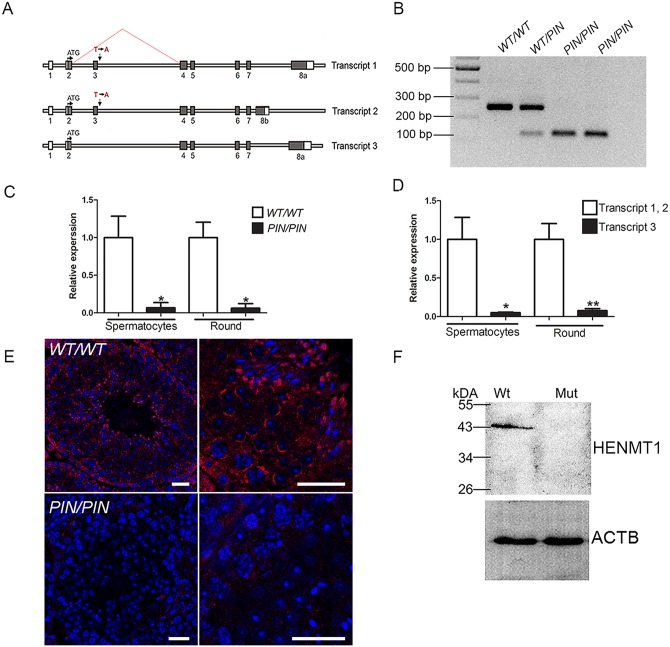
The Henmt1
PIN/PIN mutation resulted in exon 3 skipping, the production of unstable Henmt1 mRNAs and an absence of HENMT1 protein in the testis.
(A) A schematic representation of the three Henmt1 transcripts and the effect of the Henmt1
PIN/PIN on exon 3 splicing. Boxes represent exons, open bars represent introns. (B) RT-PCR analysis using primers located in exons 2 and 4 confirmed the skipping of exon 3 in the Henmt1
PIN allele. (C) qPCR analysis of Henmt1 transcript 1 and 2 levels in Henmt1
PIN/PIN and Henmt1
WT/WT spermatocytes and round spermatids (round). 8 weeks old, n = 3 /genotype (* p<0.05, mean ± SD). (D) The relative expression of Henmt1 transcripts 1 and 2, and transcript 3 in Henmt1
WT/WT spermatocytes and round spermatids. 8 weeks old. n = 3 /genotype (p*<0.05, ** p<0.01, mean ± SD). (E) HENMT1 localization (red) in Henmt1
WT/WT (upper two panels) and 8 week old Henmt1
PIN/PIN testes (lower two panels). DNA is labelled with DAPI (blue). (F) A representative western blot for HENMT1 in 8 week old Henmt1
WT/WT and Henmt1
PIN/PIN testes. Beta actin was used as a loading control. Where relevant a two-tailed unpaired student T-test was performed for statistical analyses. Scale bars = 50μm.